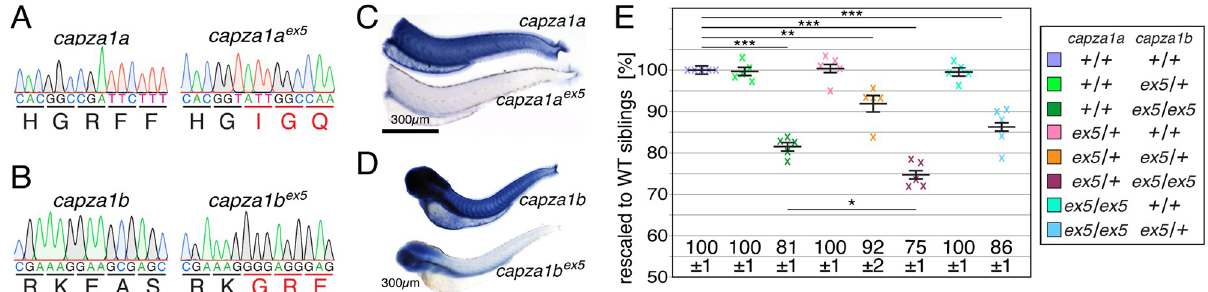
Fig 4. The muscle integrity is compromised in capza1a ex5 but not capza1b ex5 loss-of-function mutants. (A) capza1a ex5 mutants harbour an insertion of 20 bp into exon 5 of capza1a , resulting in a frame shift. (B) The mutant allele capza1b ex5 was generated by deletion of 23 bp and insertion of 1 bp into exon 5 of capza1b , causing a frame shift. (C) At 3 dpf, in situ hybridization showed that the trunk expression of capza1a found in siblings was strikingly reduced in capza1a ex5 homozygotes. (D) At 3 dpf, whole-mount in situ hybridization showed that the expression of capza1b was severely reduced in capza1b ex5 homozygotes compared to siblings. (E) At 3 dpf, the birefringence of single capza1a ex5/+ and capza1b ex5/+ heterozygotes as well as single capza1a ex5/ex5 homozygotes was comparable to WT siblings ( capza1a +/+ ; capza1b +/+ , capza1a ex5/+ ; capza1b +/+ , capza1a +/+ ; capza1b ex5/+ and capza1a ex5/ex5 ; capza1b +/+ all were 100 ± 1%). However, single capza1b ex5/ex5 homozygotes were significantly reduced in their birefringence and larvae that were additionally heterozygous for capza1a ex5/ex5 were significantly reduced further ( capza1a +/+ ; capza1b ex5/ex5 were 81 ± 1% and capza1a ex5/+ ; capza1b ex5/ex5 were 75 ± 1%). In addition, compound heterozygotes capza1a ex5/+ ; capza1b ex5/ex5 and capza1a ex5/ex5 homozygotes that were capza1b ex5/+ heterozygous were also significantly reduced in their birefringence ( capza1a ex5/+ ; capza1b ex5/+ were 92 ± 2% and capza1a ex5/ex5 ; capza1b ex5/+ were 86 ± 1%). Data are mean ± SEM; � P < 0.05, �� P < 0.01 and ��� P < 0.001 calculated by one-way ANOVA with post hoc Tukey’s test; n = 5 clutches. Scale bar sizes are 300 μ